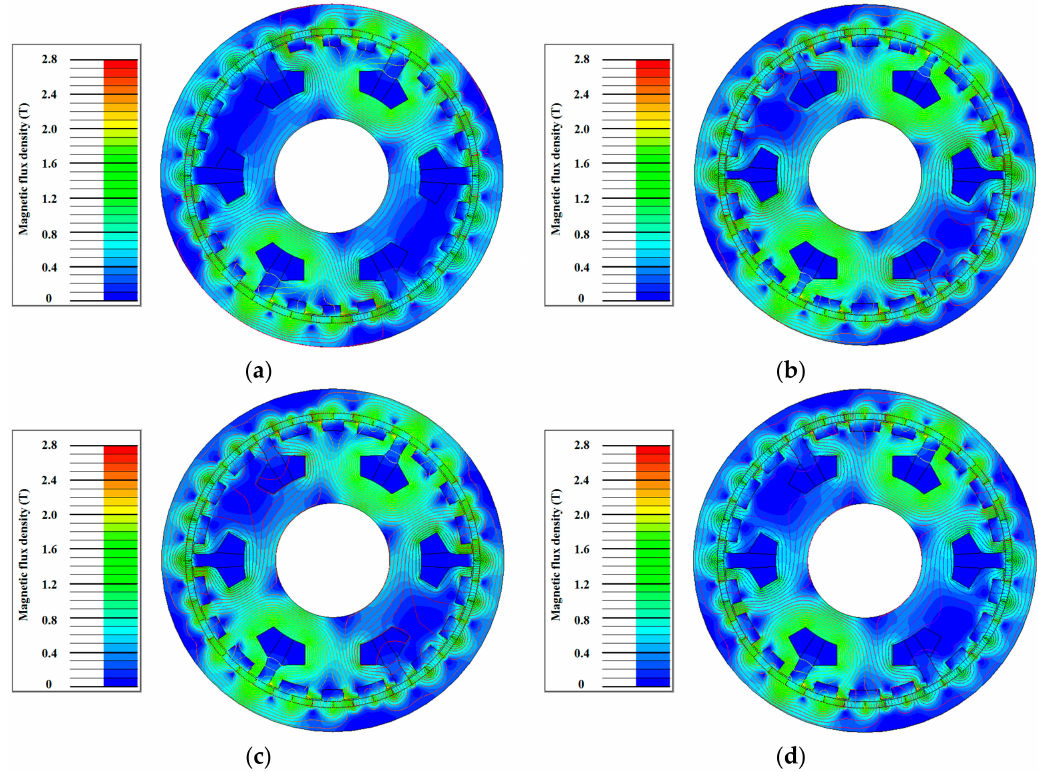
Figure 12. Flux density distributions for the basic and optimal models under load condition. ( a ) Basic model; ( b ) OM1; ( c ) OM2; ( d )